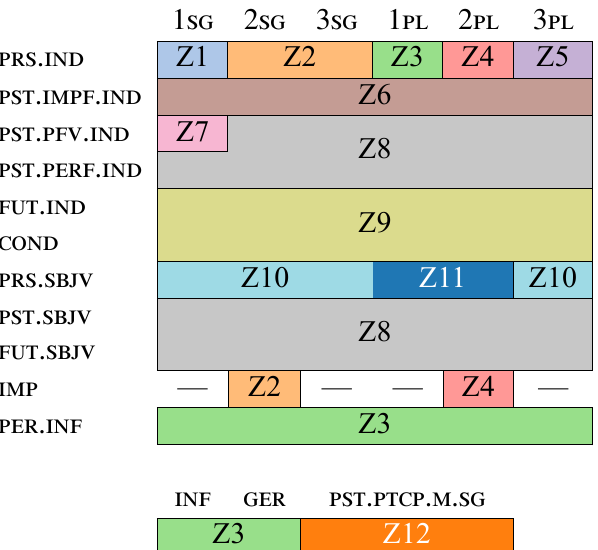
Table 17: Partition into zones of interpredictability of the verbal paradigm of European